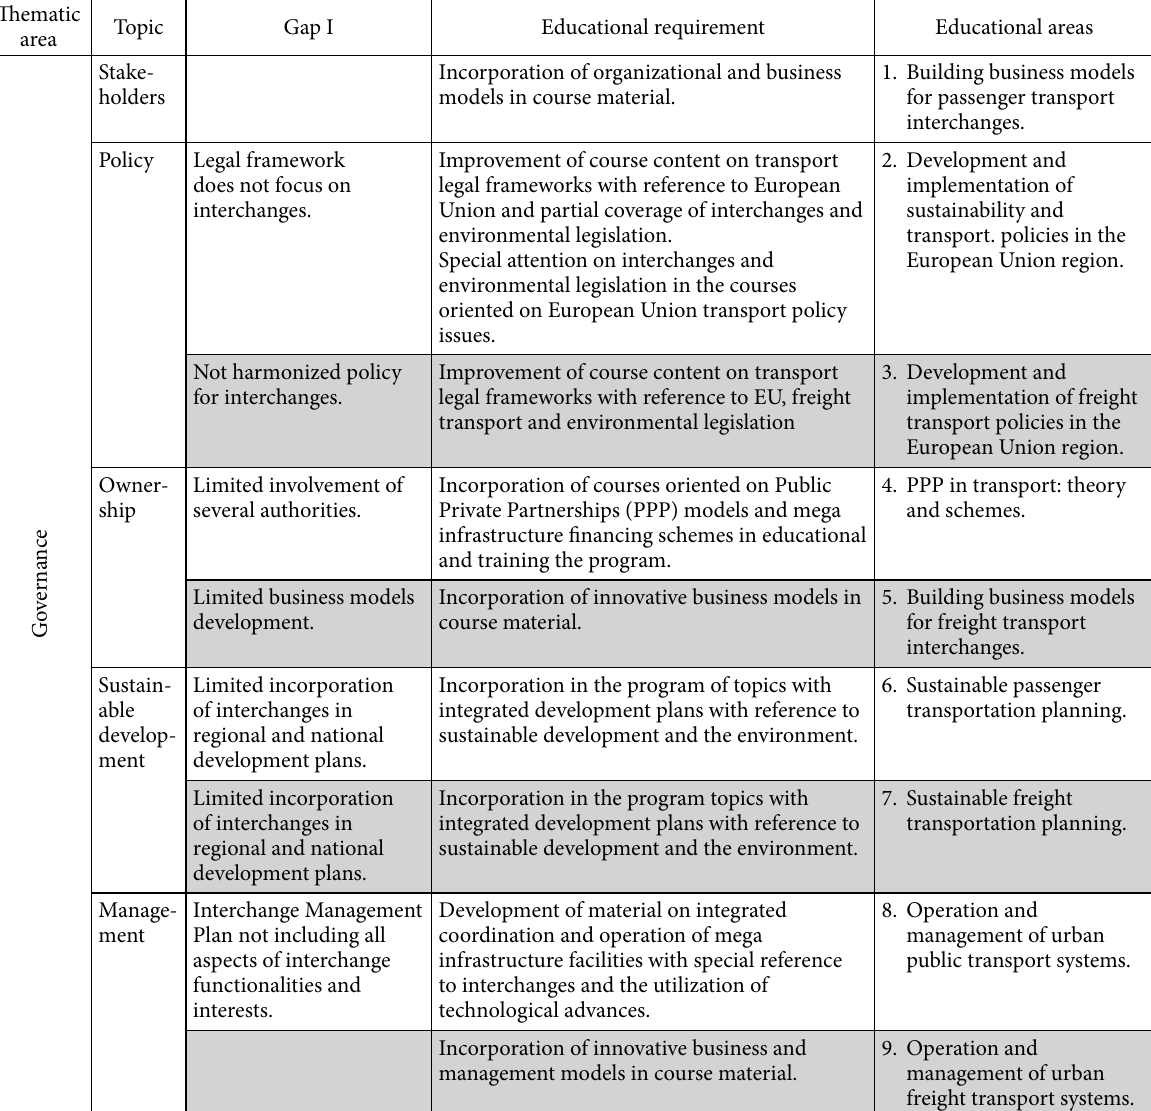
Table 7. Educational requirements for Latvia and the region (Gap analysis